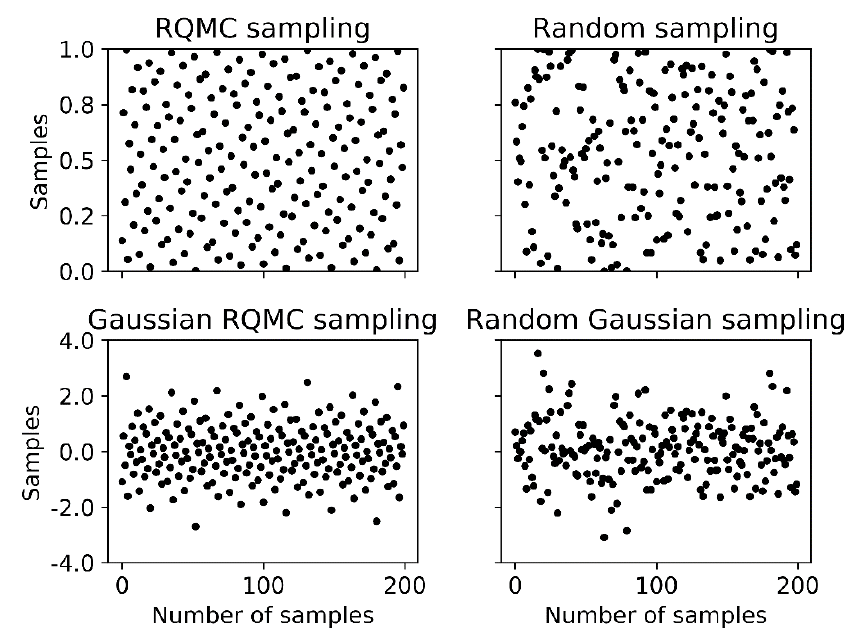
Figure 1 . The 200 points investigated for the randomized quasi-Monte Carlo (RQMC) sampling, pseudo-random sampling, and the corresponding Gaussian sampling with a Sobol sequence.